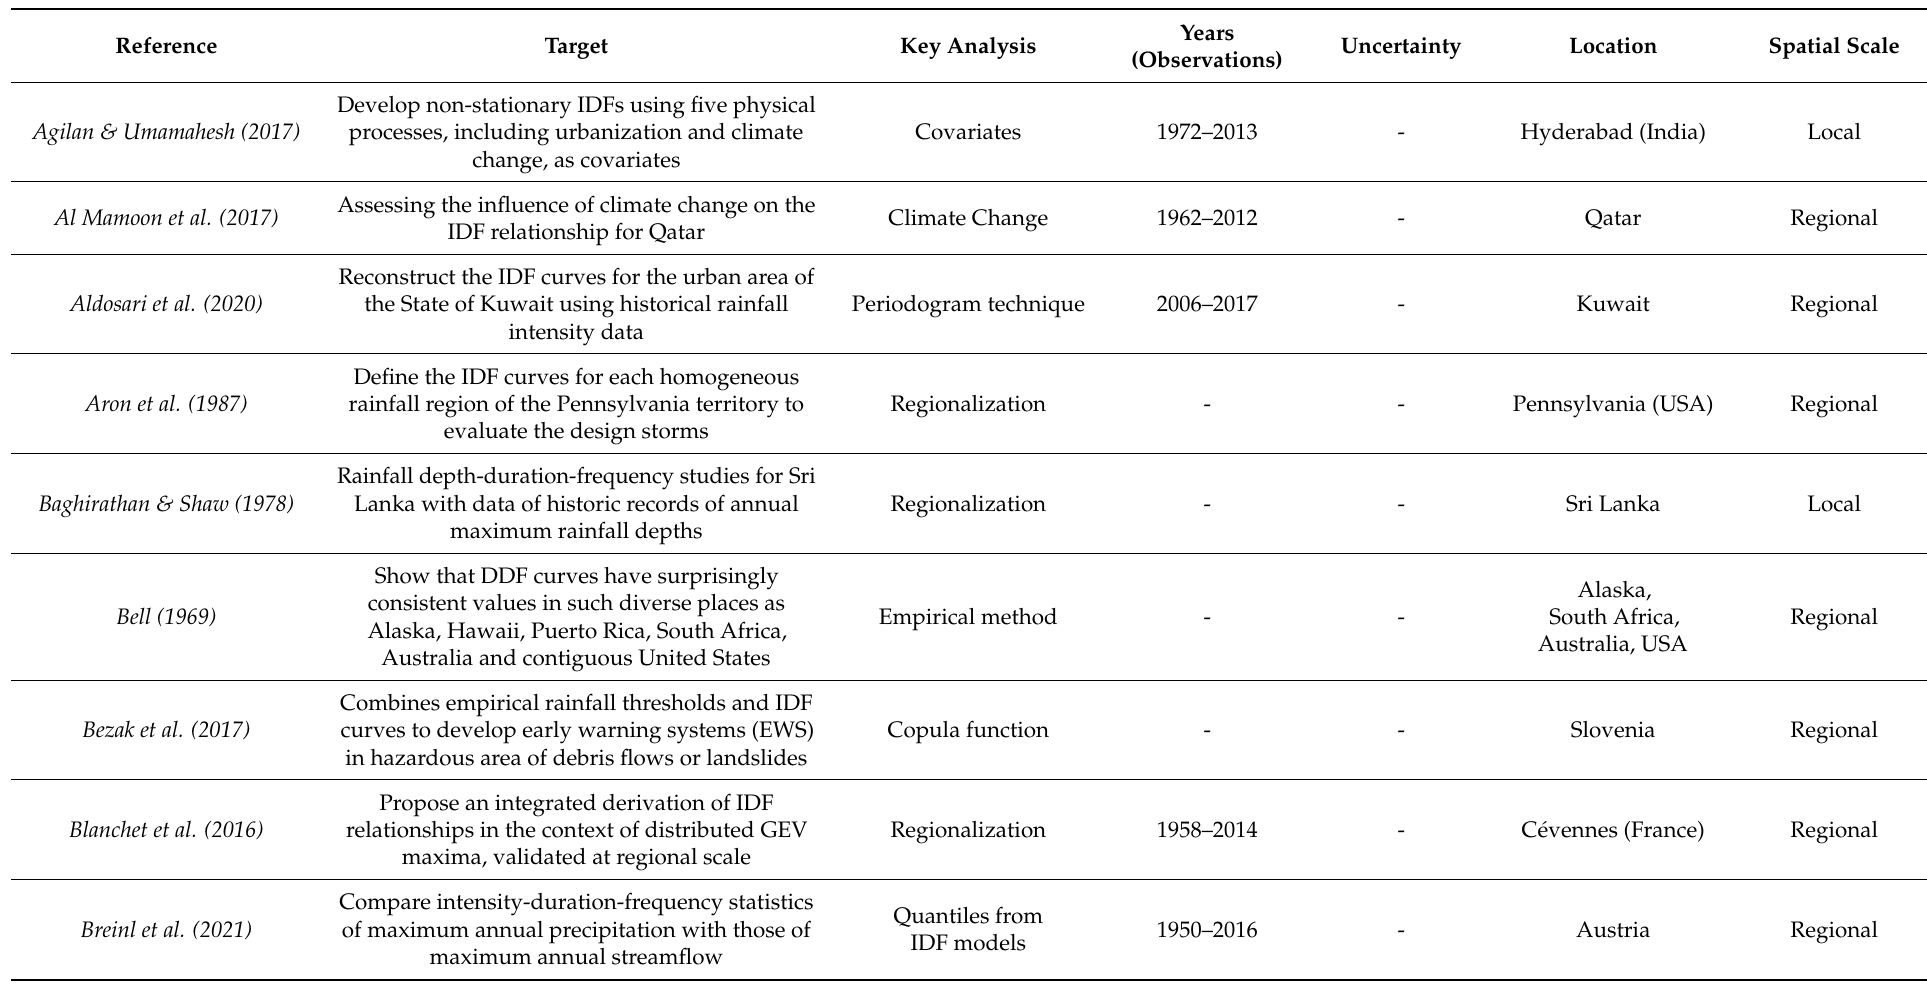
Table 2. Papers developing IDFs using a rain-gauge